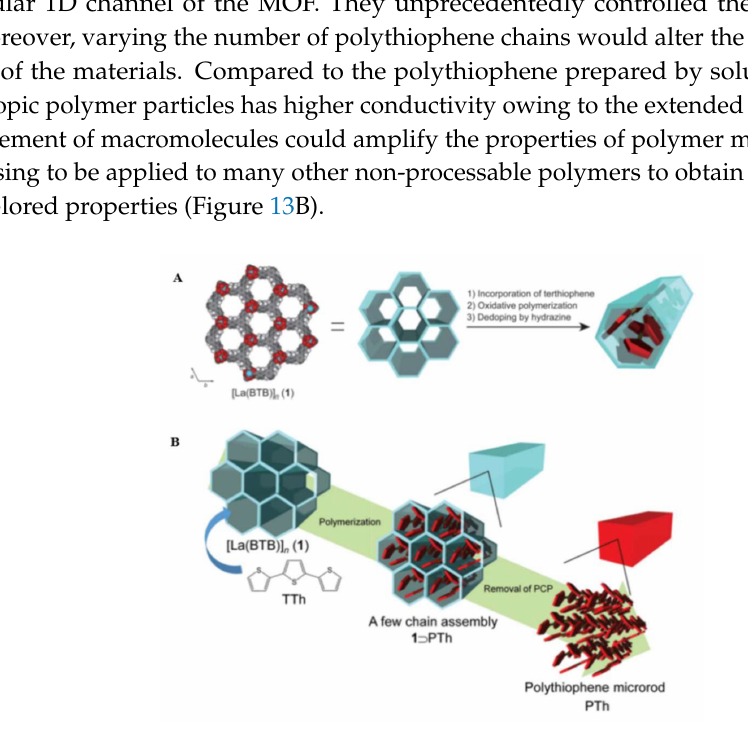
Figure 13. ( A ) Scheme showing the unsubstituted polythiophene inside the 1D nanochannels of La(BTB). ( B ) Scheme showing the polymerization inside the nanochannels of MOF [89,90]. Copyright 2019 by John Wiley & Sons, Inc. and 2017, Royal Society of